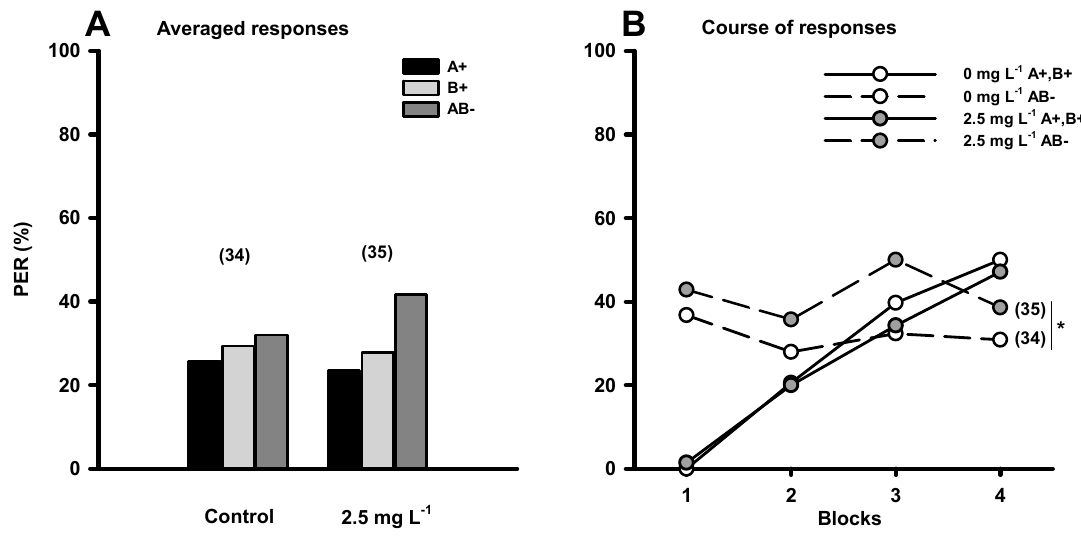
Figure 2. E ff ect of an acute exposure to GLY on forager honey bee non-elemental olfactory learning. Percentage of bees captured at the hive entrance that responded to the rewarded conditioned stimuli (CS + ; A + , B + ) and the unrewarded conditioned stimulus (CS − ; AB − ) by extending their proboscis (% PER) in a negative patterning olfactory conditioning procedure. The unconditioned stimulus consisted of either sucrose solution alone (control) or sucrose solution with 2.5 mg L − 1 GLY. ( A ) Average of % PER for each treatment across all trials of A + , B + and AB − for both groups. ( B ) % PER to the rewarded stimulus (A + , B + ; solid lines) and to the unrewarded stimulus (AB − ; dashed lines) for both treatments. The number of bees evaluated in each treatment is shown in brackets above each group of bars ( A ) and beside each curve ( B ). * p < 0.05 (two-way ANOVA). Reproduced with permission from Herbert and co-workers, Journal of Experimental Biology; published by The Company of Biologists, 2014.